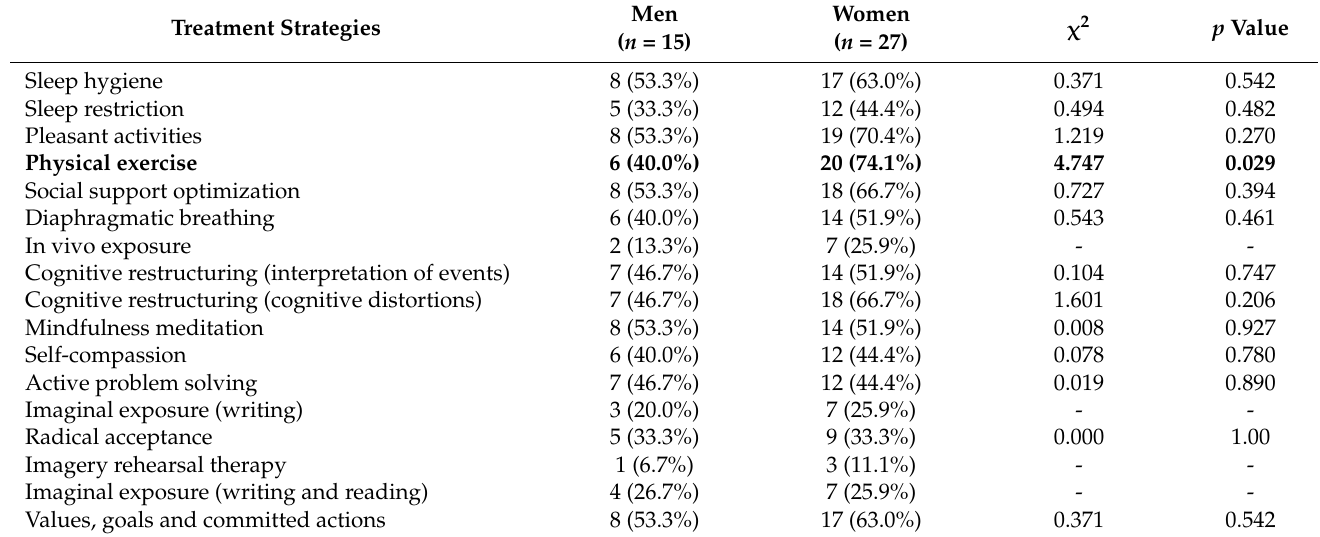
Table 5. Subjective appreciation of treatment strategies by gender: intent to